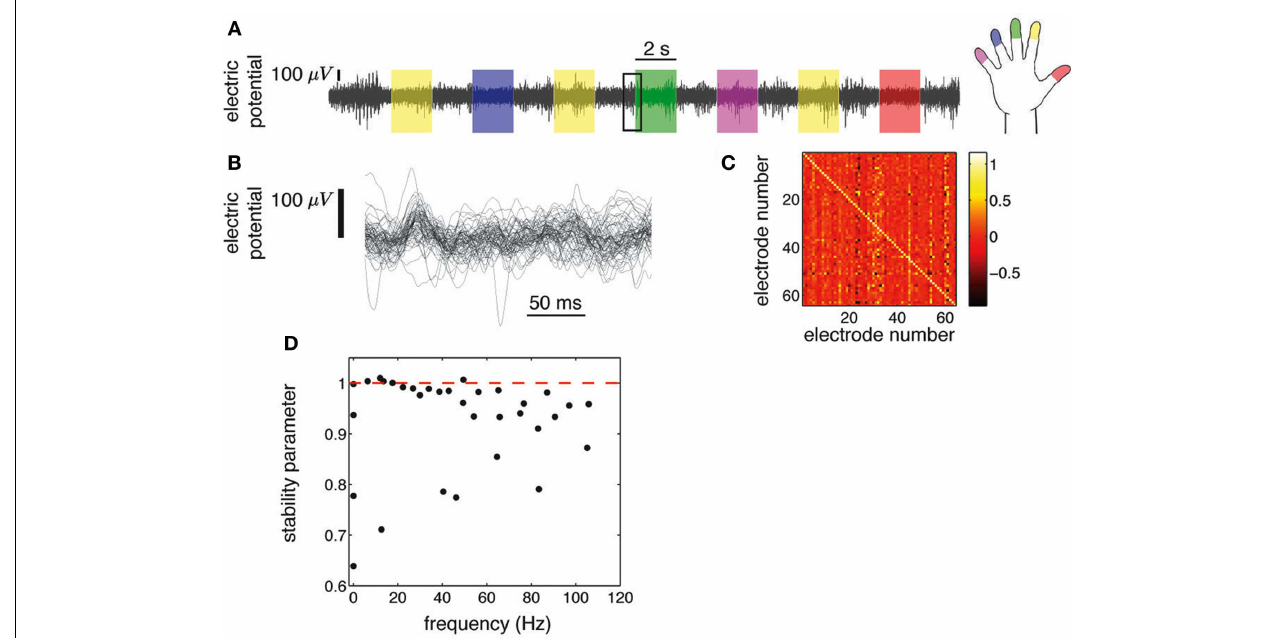
corresponding to 250ms [rectangular area in (A) ], showing all 64 electrodes. (C) Regression matrix corresponding to the AR(1) model fitted to the time series shown in (B) . (D) Eigenvalues of the matrix shown in (C) . Each complex eigenvalue is characterized by a frequency and a stability parameter (absolute